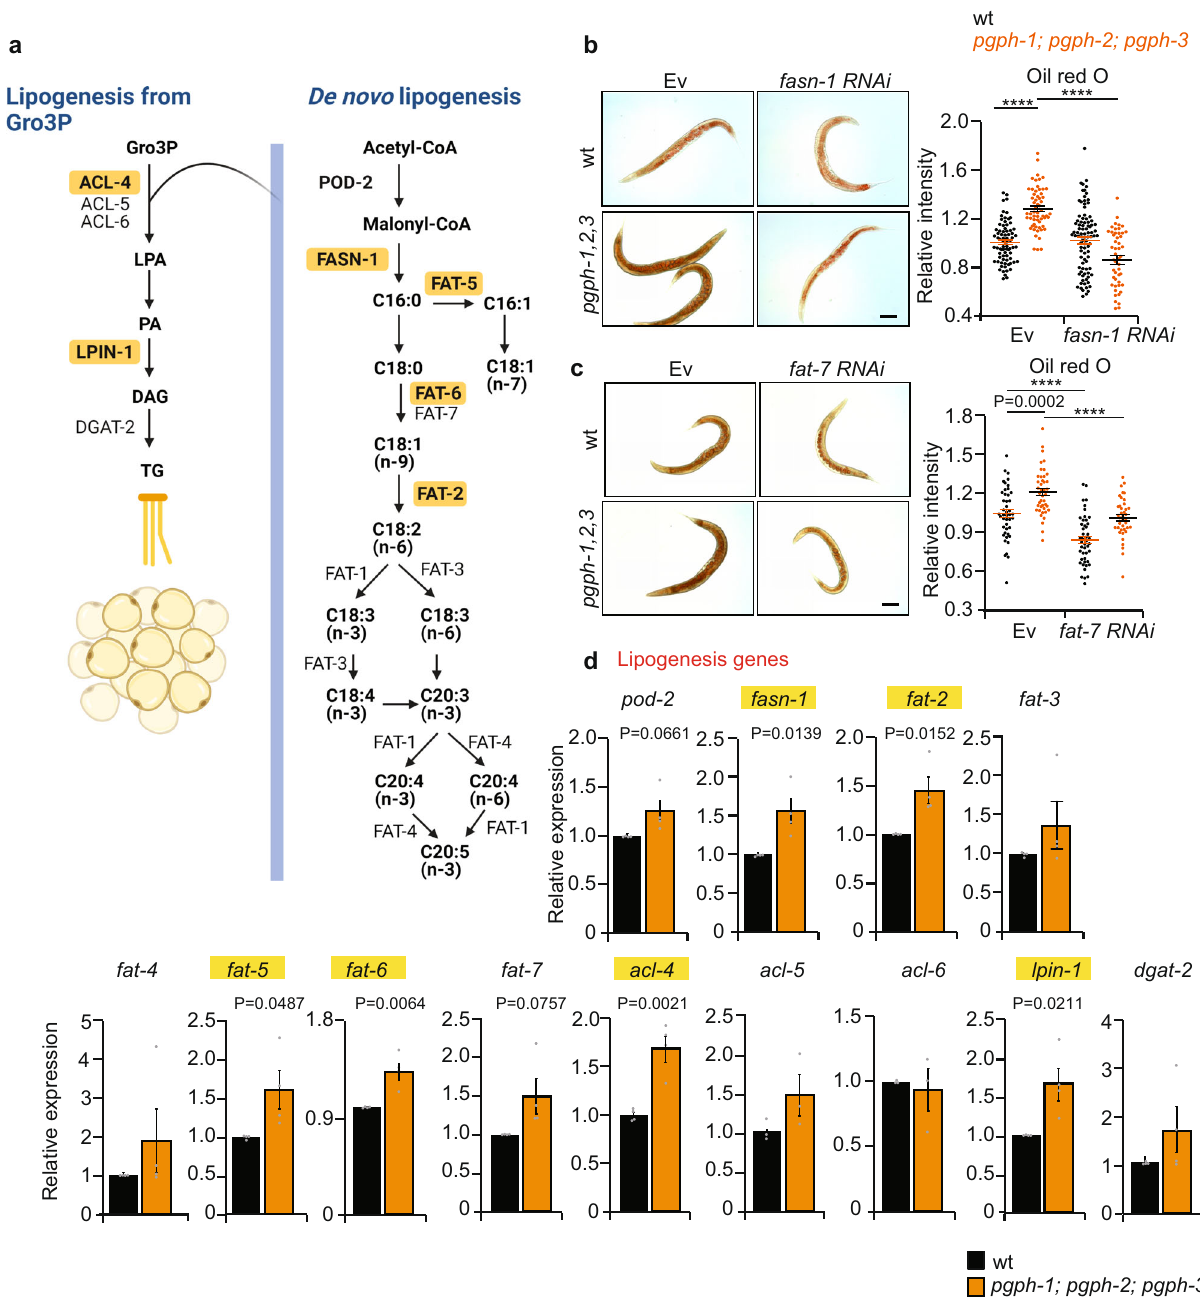
Fig. 2 Enhanced lipogenesis is required for the fat accumulation in triple pgph mutant animals. a Scheme showing the lipogenesis pathway in C. elegans highlighting in yellow the genes that are signi fi cantly induced in pgph-1; pgph-2; pgph-3 mutant animals at basal level. b , c Oil red O staining and quanti fi cation in WT and pgph-1; pgph-2 ; pgph- 3 mutant 1-day adult animals treated or not with fasn-1 RNAi ( b ) or fat-7 RNAi ( c ). Scale bars indicate 50 µ m. Sample numbers for b : n = 76 (WT-Ev), n = 59 ( pgph-1; pgph-2; pgph-3 -Ev) and n = 93 (WT- fasn-1 RNAi), n = 50 ( pgph-1; pgph-2; pgph-3 - fasn-1 RNAi). Sample numbers for c : n = 45 (WT-Ev), n = 42 ( pgph-1; pgph-2; pgph-3 -Ev), and n = 47 (WT- fat-7 RNAi), n = 39 ( pgph-1; pgph-2; pgph-3 - fat-7 RNAi). Data represent mean ± SEM from two independent experiments. P -values were obtained by one-way ANOVA with the Bonferroni test. d Relative expression of indicated genes in WT animals and pgph-1; pgph-2; pgph-3 synchronized young adult animals. Genes that are signi fi cantly induced are highlighted in yellow. Data represent mean ± SEM, n = 4 independent experiments. P -values were obtained by the student ’ s two-tailed t -test. Signi fi cance in all fi gures: **** P < 0.0001. Data are provided as a Source Data fi